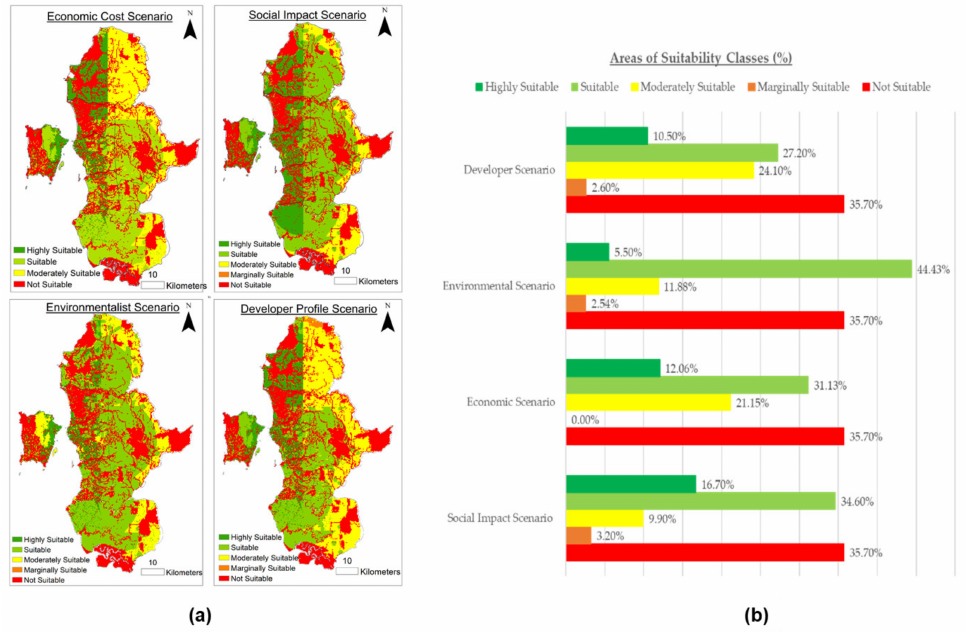
Figure 9. ( a ) The suitability maps for the different scenarios, ( b ) the coverage of the suitability classes for the different